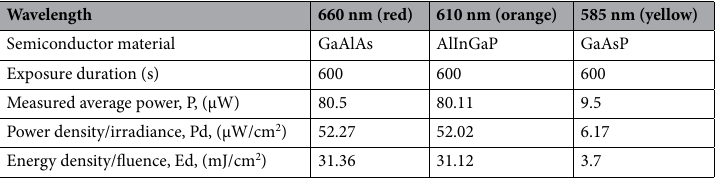
Table 1. LED exposure system